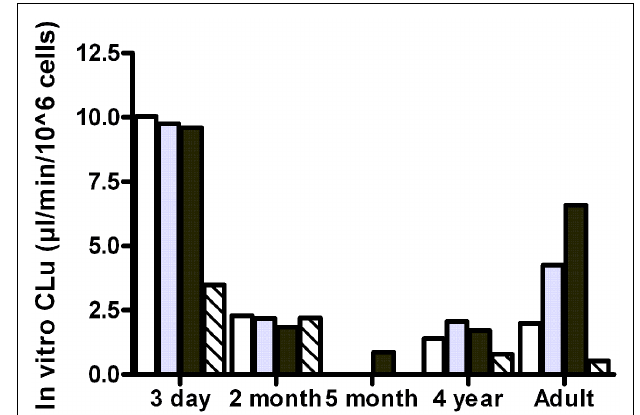
FIGURE 3 | In vitro clearance of oxycodone based on unbound concentration ( in vitro CLu) in cryopreserved human hepatocyte at